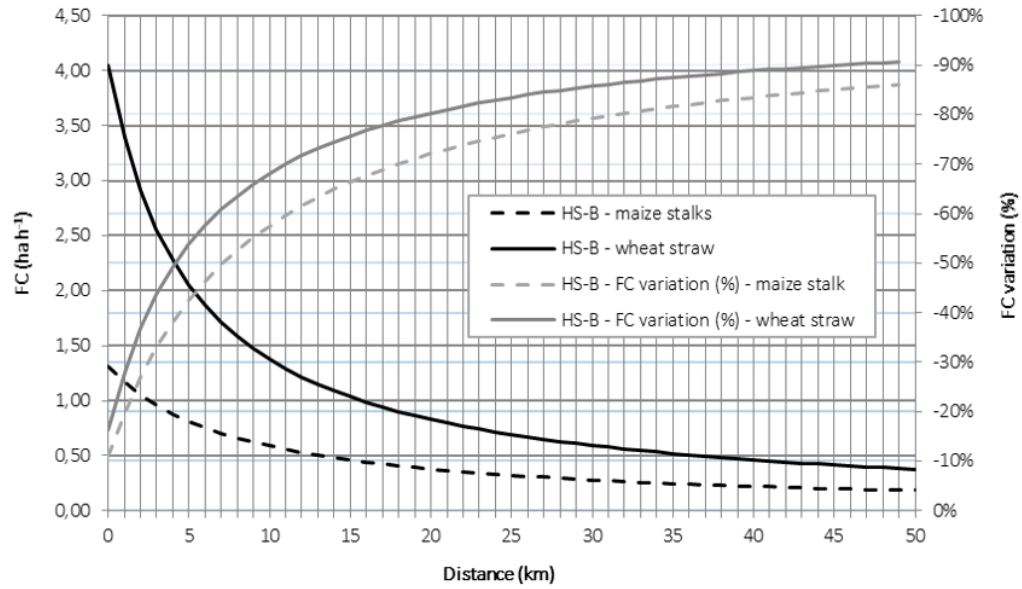
Figure 2. Trend in field capacity (FC) of the harvesting system “B” (HS-B) and its percentage variation in relation to transport distance for both wheat straw and maize stalks.